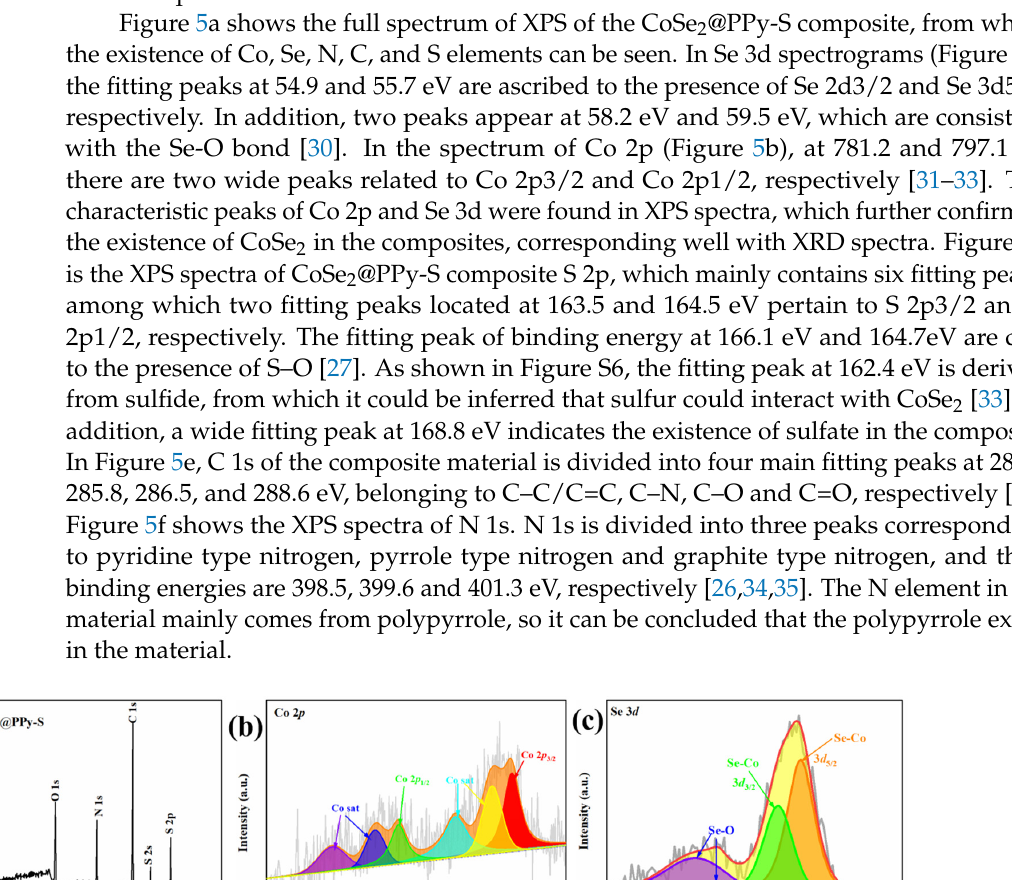
Figure 4e is the SEM picture of CoSe 2 @PPy-S composite. The basic morphology of